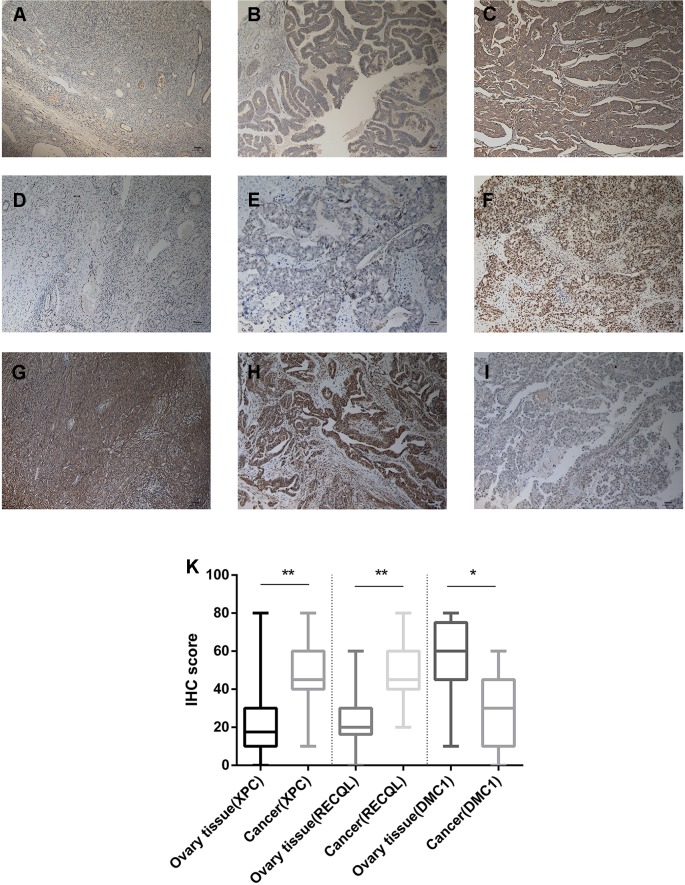
Immunohistochemistry for XPC, RECQL, and DMC1. Samples of ovarian tissue (N = 40) and ovarian cancer (N = 200). Cancer-adjacent ovarian tissue samples with weak immunostaining scores for (A)
XPC or (D)
RECQL or strong immunostaining scores for (G)
DMC1. Ovarian cancer sample of weak and strong immunostaining score for XPC
(B, C) or RECQL
(E, F) and DMC1
(I, H), respectively. Expression of the XPC, RECQL, and DMC1 genes is depicted in (K) slides (X 100). *p < 0.05, **p < 0.01.